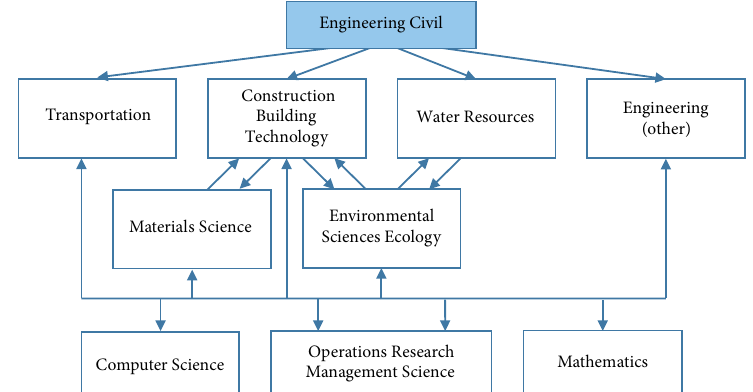
Fig. 2. Interconnections of research areas